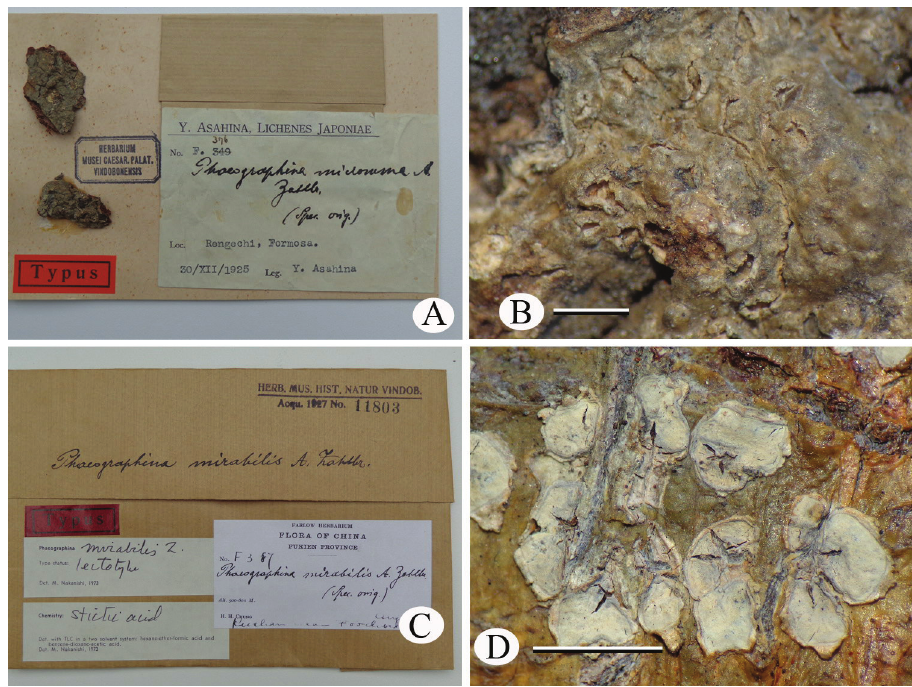
Figure 4. A–B Phaeographina micromma Zahlbr. ( Asahina 376 ) C–D Phaeographina mirabilis Zahlbr. ( Chung 387 ). Scale bars =